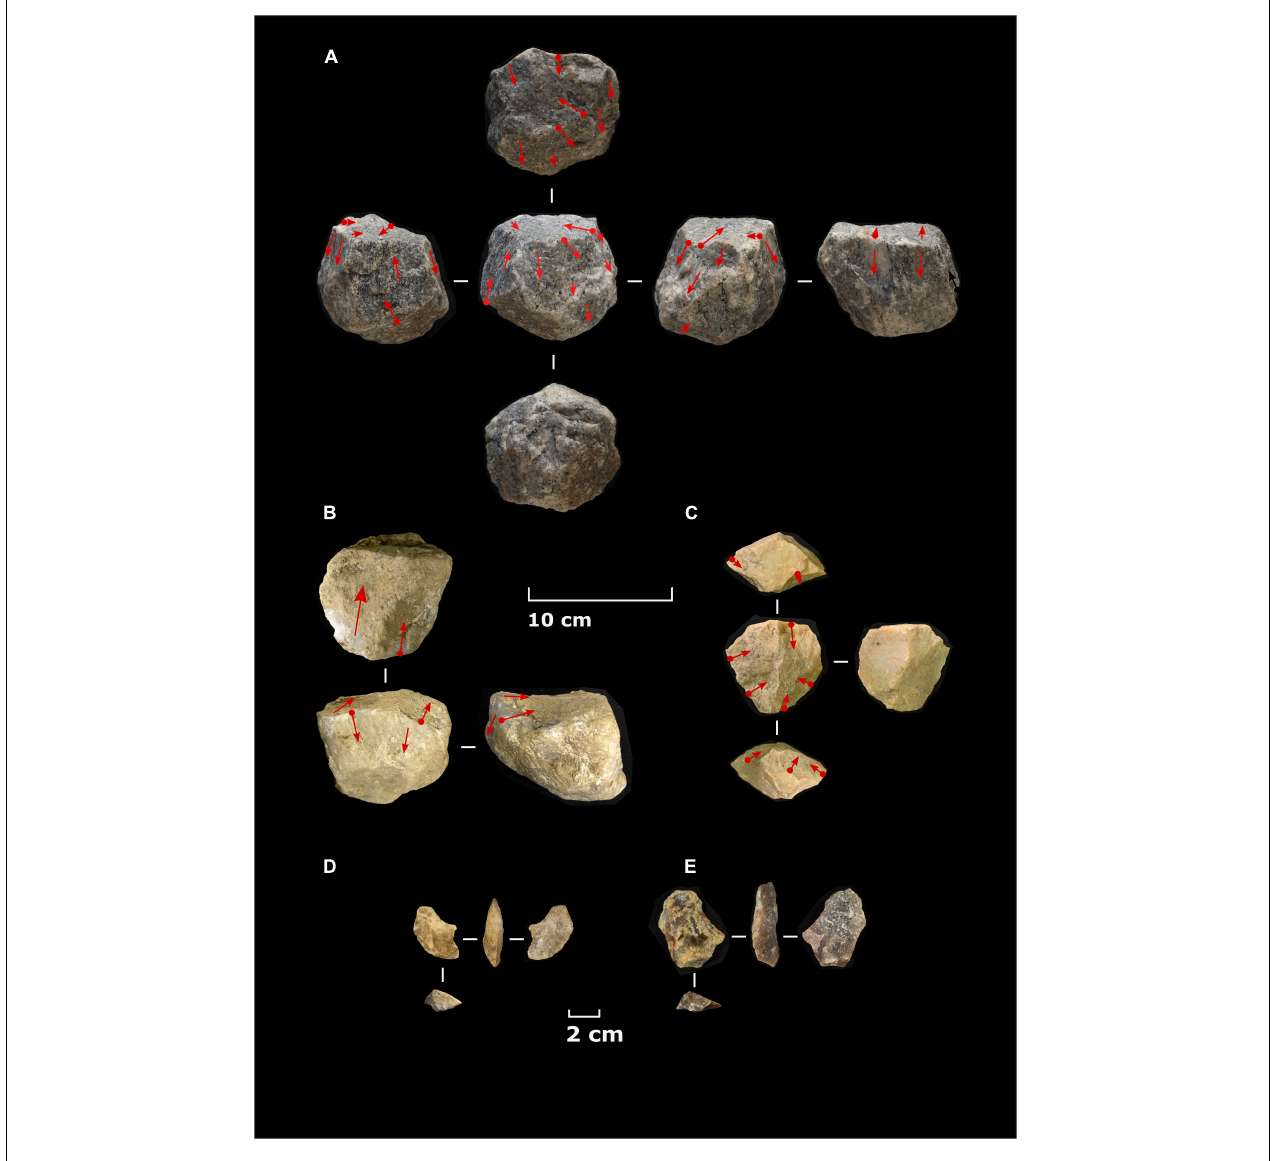
FIGURE 2 | Selection of stone tools from Phase I. (A) Quartzite multipolar multifacial core with technical schemes. (B) Quartzite bifacial orthogonal core with technical schemes. (C) Quartzite unifacial centripetal core with technical schemes. (D,E) Quartzite flakes. Red arrows indicate the directions of flake’s